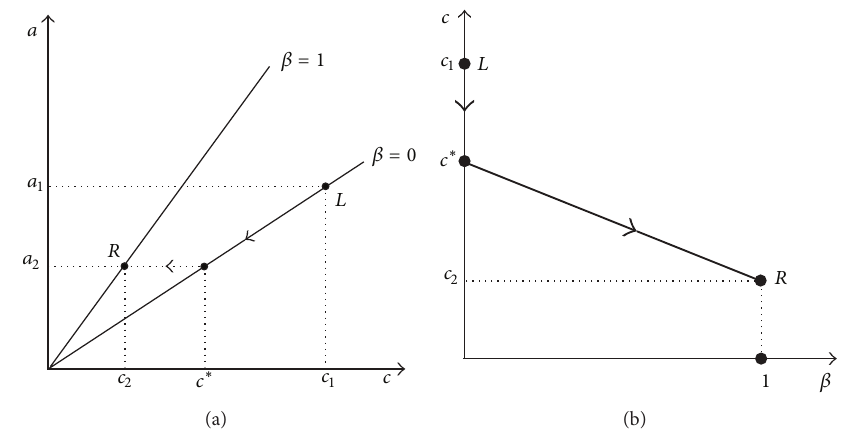
Figure 6: Solution of the auxiliary problem. (a) Adsorption isotherm for chemical for different water salinities and the Riemann problem solution; (b) Riemann problem solution on the plane of chemical concentration c and salinity 𝛽 .